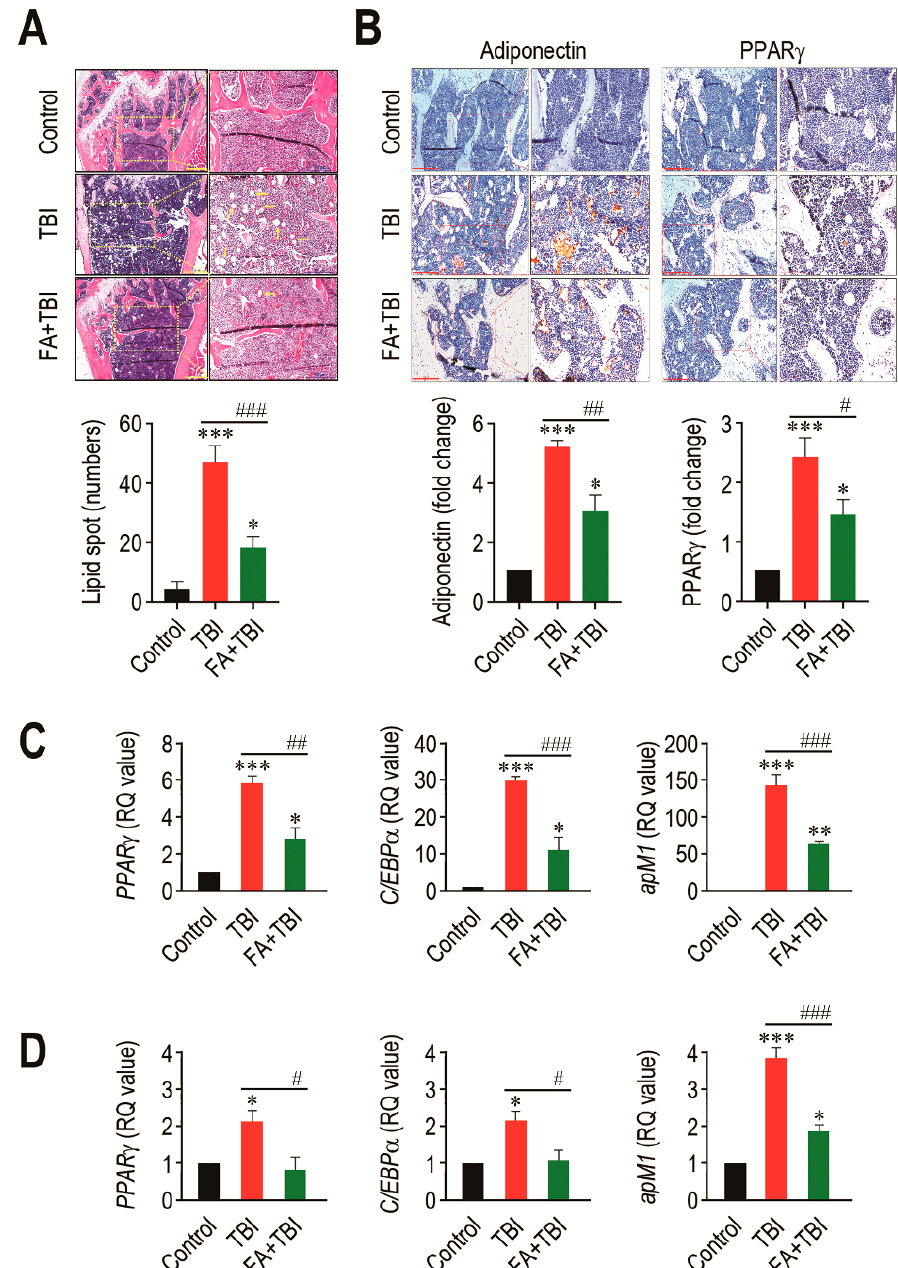
Figure 5. Long-term administration of ferulic acid inhibits TBI-mediated adipogenic activation in BM of mice. ( A ) Lipid accumulation in trabecular regions of mice groups was determined by H&E staining at 60 days post-TBI. Yellow arrows indicate the lipid spots formed in the bone. Scale bar = 500 µ m. ( B ) Levels of adiponectin and PPAR γ in BM of mice groups were measured by IHC assay at 60 days post-TBI. Scale bar = 200 µ m. Number of lipid spots and relative intensity of adiponectin and PPAR γ (fold change) in BM were calculated from four different samples. Expression levels of PPAR γ , C/EBP α , and apM1 in BM cells from mice groups were determined by qRT-PCR assay at ( C ) 30 and ( D ) 60 days post-TBI ( n = 4). All data are expressed as the mean ± SD. * p < 0.05, ** p < 0.01, and *** p < 0.001 compared with control group; # p < 0.05, ## p < 0.01, and ### p < 0.001 compared with TBI group.